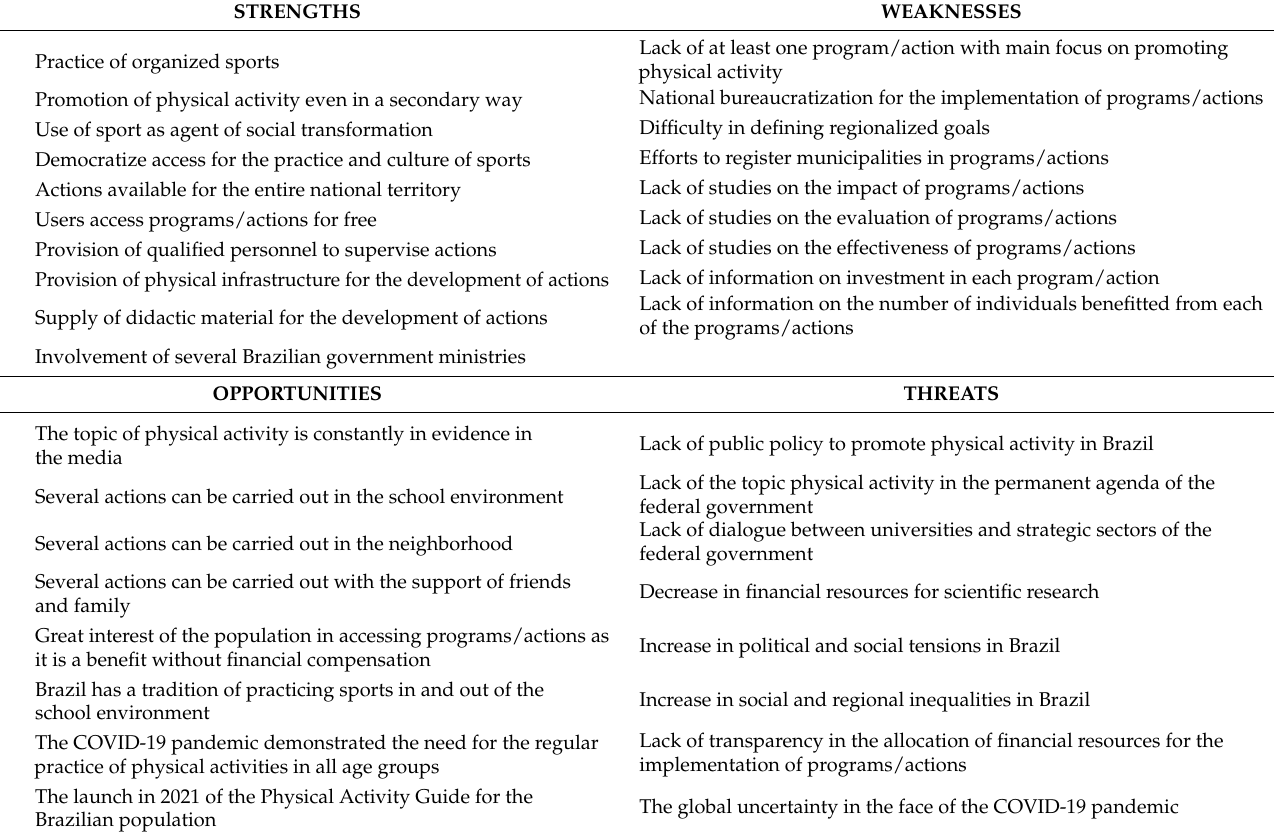
Table 2. Analysis of Strengths, Weaknesses, Opportunities and Threats (SWOT) of programs/actions to promote physical activity for children and adolescents in Brazil.